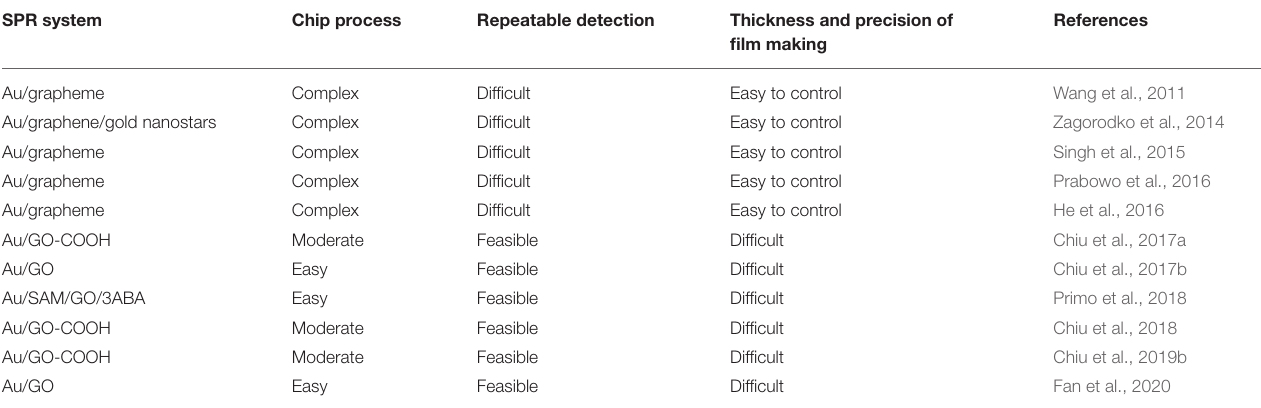
TABLE 2 | Graphene-based SPR chip, which has been successful in fabrication, advantages, and